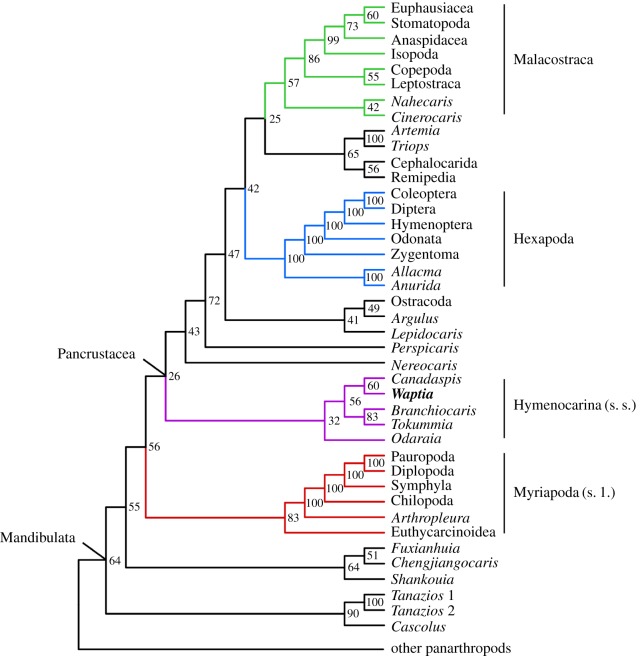
Mandibulate clade extracted from a maximum clade credibility tree of a time-calibrated Bayesian analysis of adult panarthropod relationships (Mkv + Γ model, 85 taxa, 219 characters; see electronic supplementary material, S19–S21). Numbers on the right of the nodes are posterior probabilities.